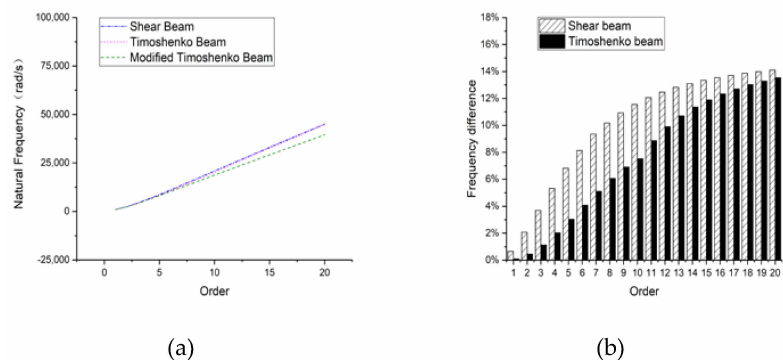
Figure 8. Natural frequencies of the 4-m-long beam: ( a ) overall frequency curve and ( b ) frequency di ff erence compared with a modified Timoshenko beam.